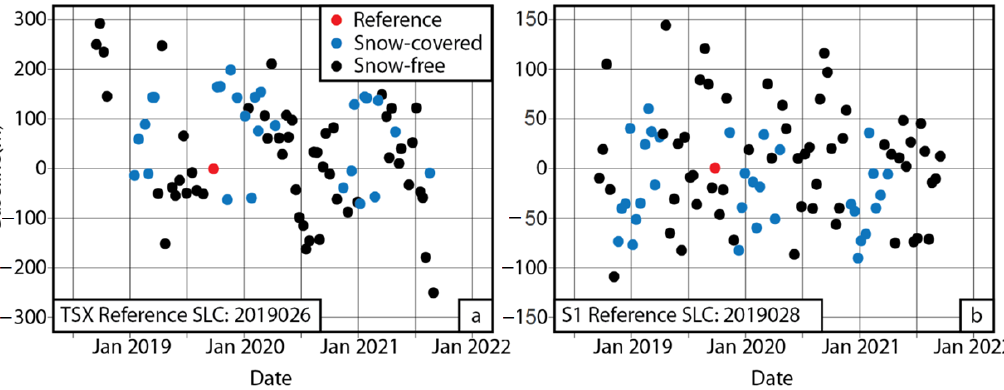
Figure 2. Perpendicular baseline in meters vs. date for all data relative to a reference date (red) showing snow-free (black) and snow-covered (blue) dates for TSX ( a ) and S1 ( b ).